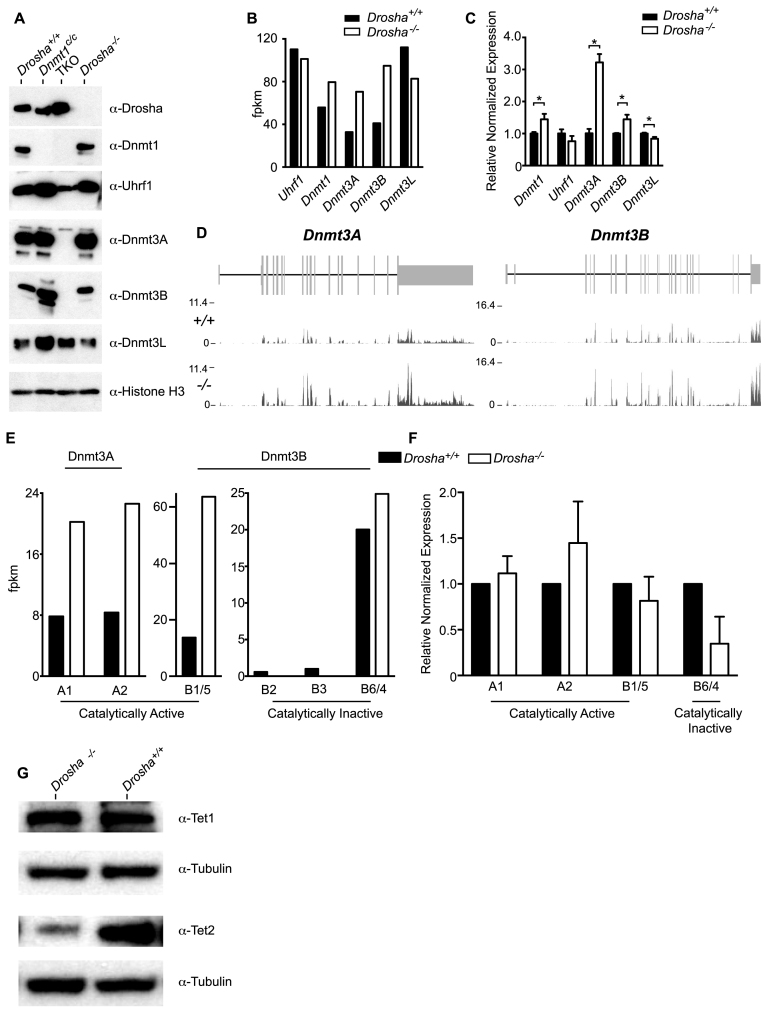
Analysis of components involved in regulating DNA methylation (A). Western blot data using the various antibodies indicated on nuclear extracts from the ES cell lines indicated. Triple Knockout (TKO) is an ES cell line deficient for all three active DNA methyltransferases (Dnmt1−/−Dnmt3A−/−Dnmt3B−/−). (B) Bar graph of RNA-seq data showing expression levels of genes indicated. (C) Bar graphs of qRT-PCR data showing expression levels of the factors indicated. Results representative of three biological replicates. For Uhrf1 levels, exact P-value = 0.0571 (Mann–Whitney test). For all other genes, P = 0.028. Gapdh used for normalization. (D) RNA-Seq data traces for Dnmt3A and Dnmt3B loci. (E) Bar graphs of RNA-seq data of different Dnmt3 isoforms indicated. (F) Same as (E), but showing Image-J quantified protein levels. (G) Western blot data using anti-Tet1 and Tet2 antibody. Anti-tubulin used as loading control.